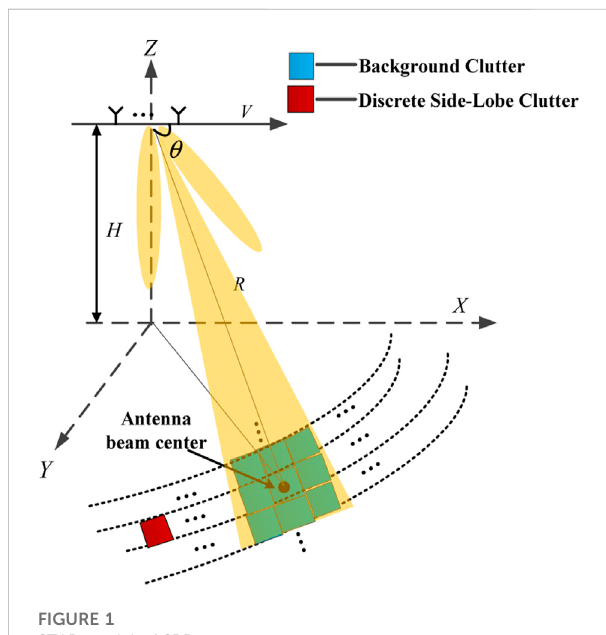
FIGURE 1 STAP model of SBR.